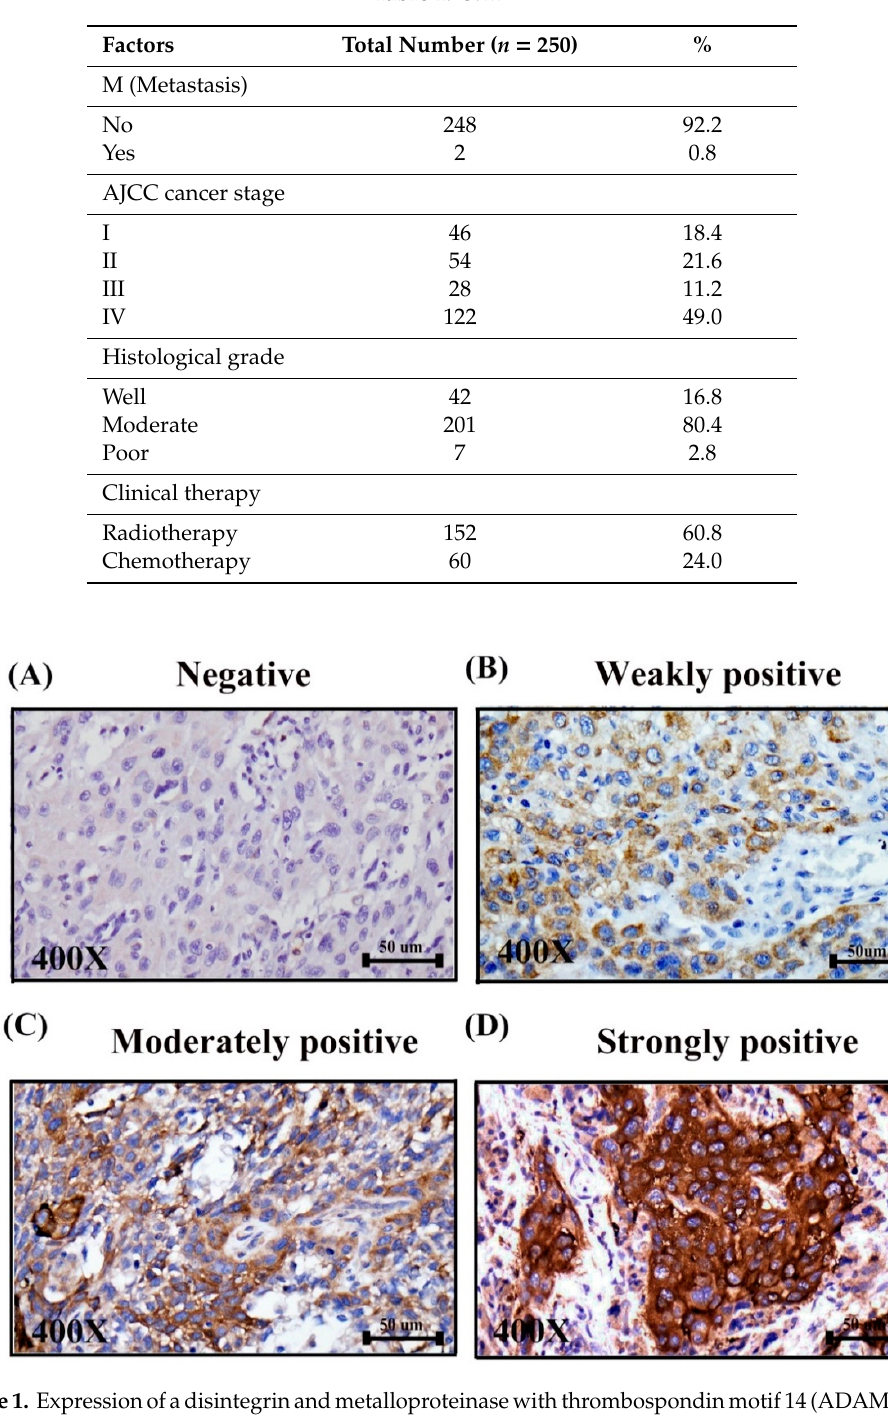
Figure1. Expressionof adisintegrin andmetalloproteinasewith thrombospondin motif14 (ADAMTS14) Figure 1. Expression of a disintegrin and metalloproteinase with thrombospondin motif 14 inOSCCasdetectedbyimmunohistochemicalstaining.( A ).NegativeexpressionofADAMTS14inOSCC (ADAMTS14) in OSCC as detected by immunohistochemical staining. ( A ). Negative expression of tissues. ( B ). Weakly positive cytoplasmic expression of ADAMTS14 in OSCC tissues. ( C ). Moderately ADAMTS14 in OSCC tissues. ( B ). Weakly positive cytoplasmic expression of ADAMTS14 in OSCC positive cytoplasmic expression of ADAMTS14 in OSCC tissues. ( D ). Strongly positive cytoplasmic tissues. ( C ). Moderately positive cytoplasmic expression of ADAMTS14 in OSCC tissues. ( D ). expression of ADAMTS14 in OSCC tissues (magnification 400 × Strongly positive cytoplasmic expression of ADAMTS14 in OSCC tissues (magnification 400×).